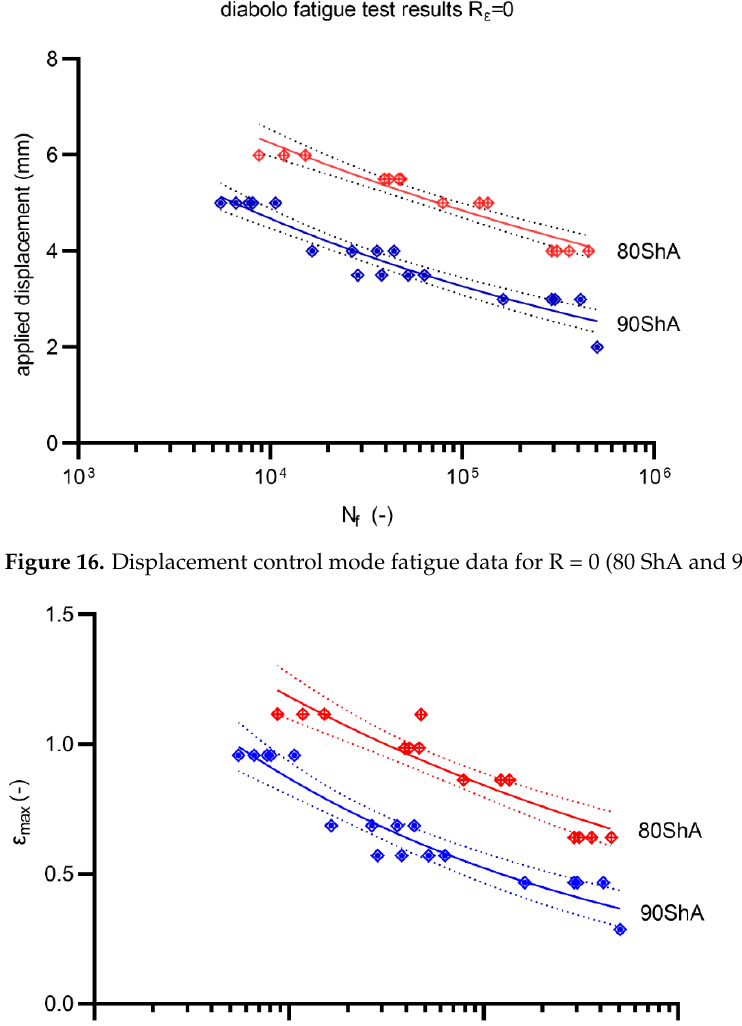
Figure 15. Energy vs. displacement for diabolo specimens used in the experimental campaign.